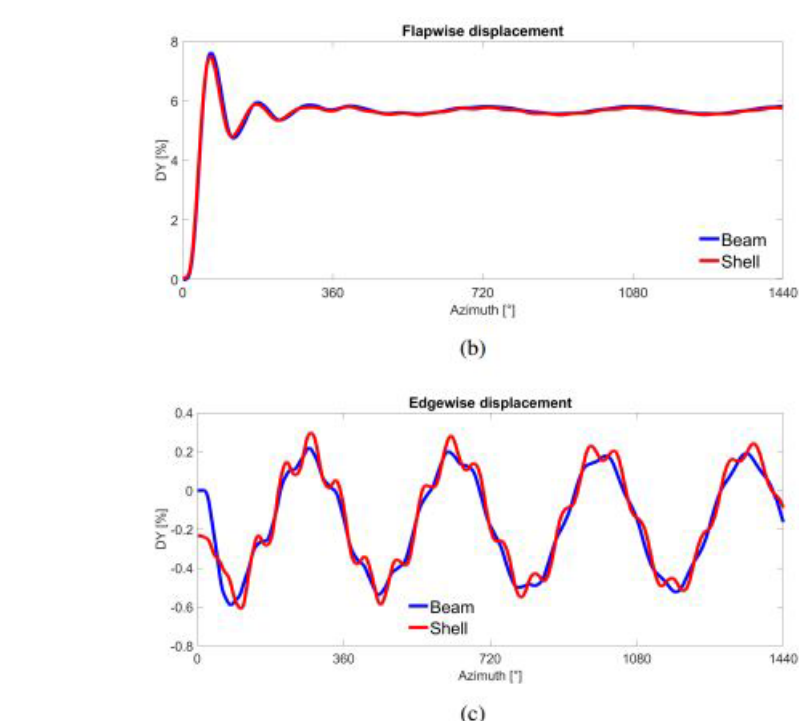
Figure 5. Logic tree of the FSI coupling.